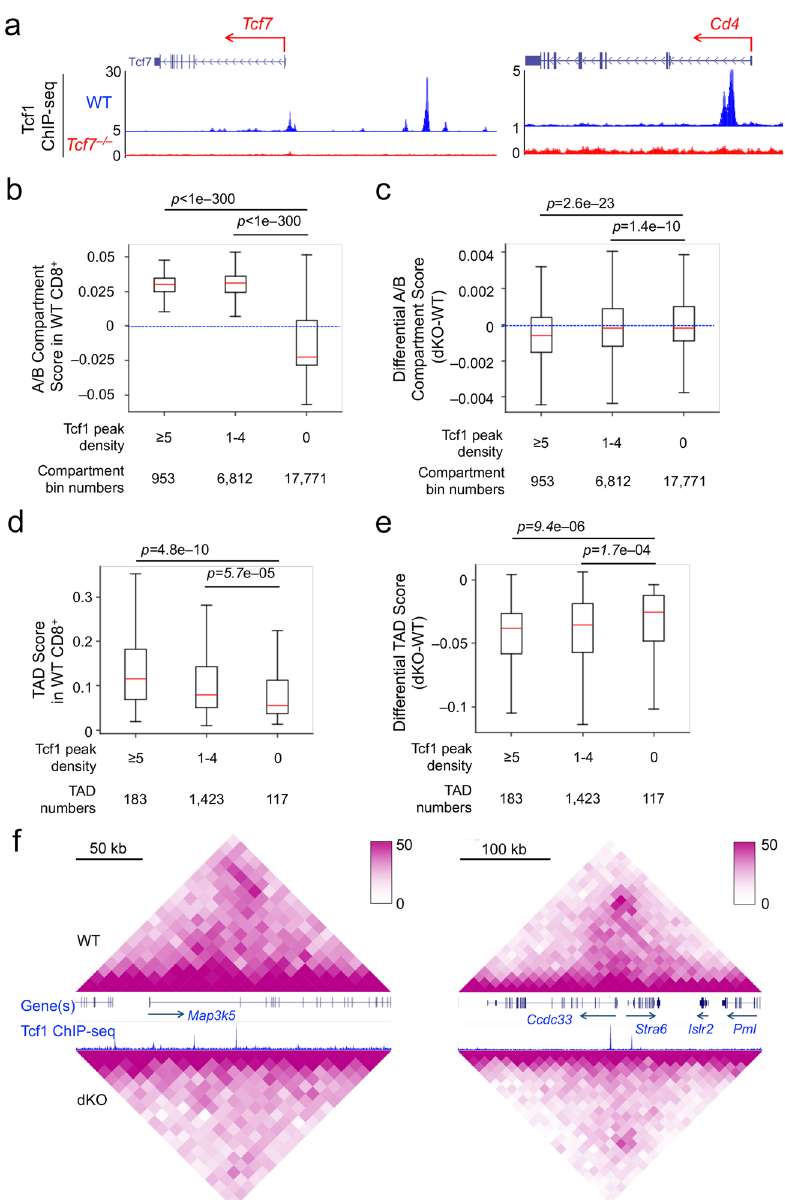
Fig. 1 Tcf1 and Lef1 regulate large-scale genomic organization in CD8 + T cells. a Tcf1 ChIP-seq tracks at the Tcf7 and Cd4 gene loci in WT and Tcf7 − / − CD8 + T cells, with gene structure and transcription orientation displayed on top of each panel. b Tcf1 binding peaks are enriched in A compartments in WT CD8 + T cells. Compartment bins were allocated into different groups based on the density of Tcf1 peaks within each bin, and the A/B compartment scores were assessed using the Eigenvector function in the Juicer package. The blue-dotted line denotes compartment score at 0. c Tcf1/Lef1 de fi ciency diminishes compartment scores in Tcf1-bound compartments. Differential A/B compartment scores were assessed between dKO and WT CD8 + T cells, and then distributed into different groups based on Tcf1 peak density. The blue-dotted line denotes a non-differential score. d Tcf1 peaks are enriched in TADs with higher scores. TADs were identi fi ed using Arrowhead and allocated into different groups based on Tcf1 peak numbers per 100kb in WT CD8 + T cells. Shown is the distribution of TAD scores in each group. e Tcf1/Lef1 de fi ciency diminishes TAD scores. Differential TAD scores were assessed between dKO and WT CD8 + T cells, and then distributed into different groups based on Tcf1 peak numbers per 100kb. In ( b – e ), red line in the middle of box denotes median, box denotes interquartile range (IQR), and whiskers denote the most extreme data points that are no more than 1.5×IQR from the edge of the box; the statistical signi fi cance was calculated using one-sided Mann – Whitney U test. f Select differential TADs detected at the Map3k5 (left) and Ccdc33 to Pml gene loci (right). Diamond graphs showing chromatin interactions in WT (top) and dKO CD8 + T cells (bottom) were extracted from WashU epigenome browser, with gene structures and Tcf1 ChIP-seq tracks in the middle. Genomic and color scales are displayed on the